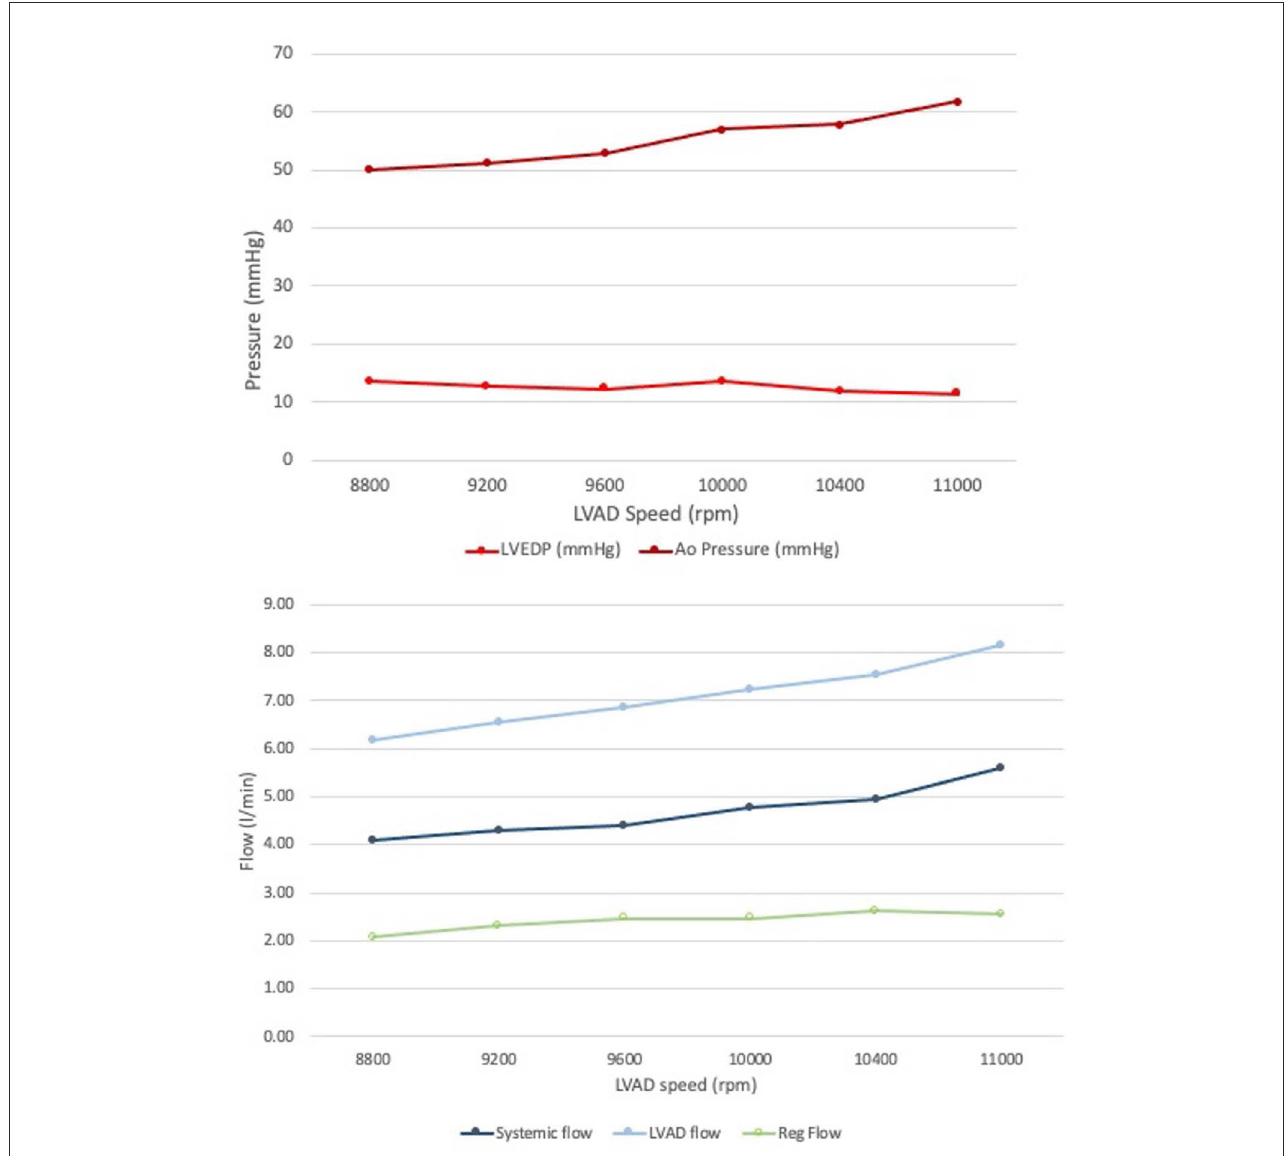
FIGURE3 Invasive measurements obtained from the mock circulatory flow loop. (Top) End diastolic pressures in the Aorta and LV. (Bottom) Forward systemic flow and LVAD flow; regurgitant flow form AR obtained by subtraction: note how the regurgitant volume did not significantly change at increased LVAD